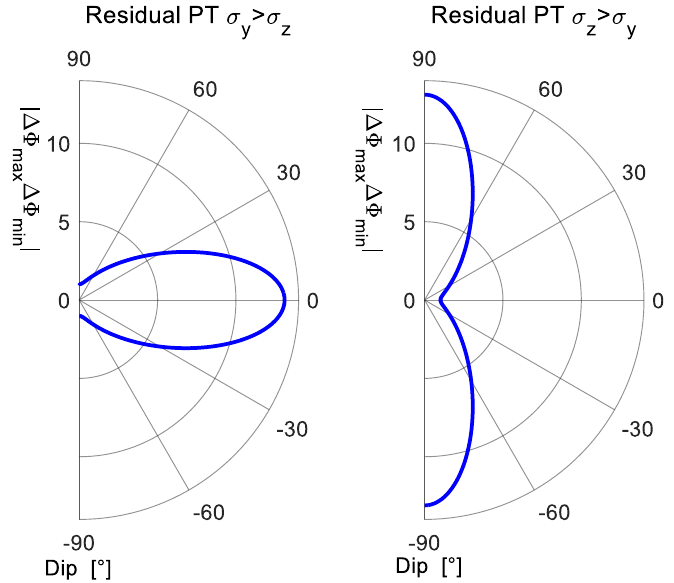
Figure 17. Sensitivity analysis of the dip angle of the injection fracture model to the residual phase tensor.